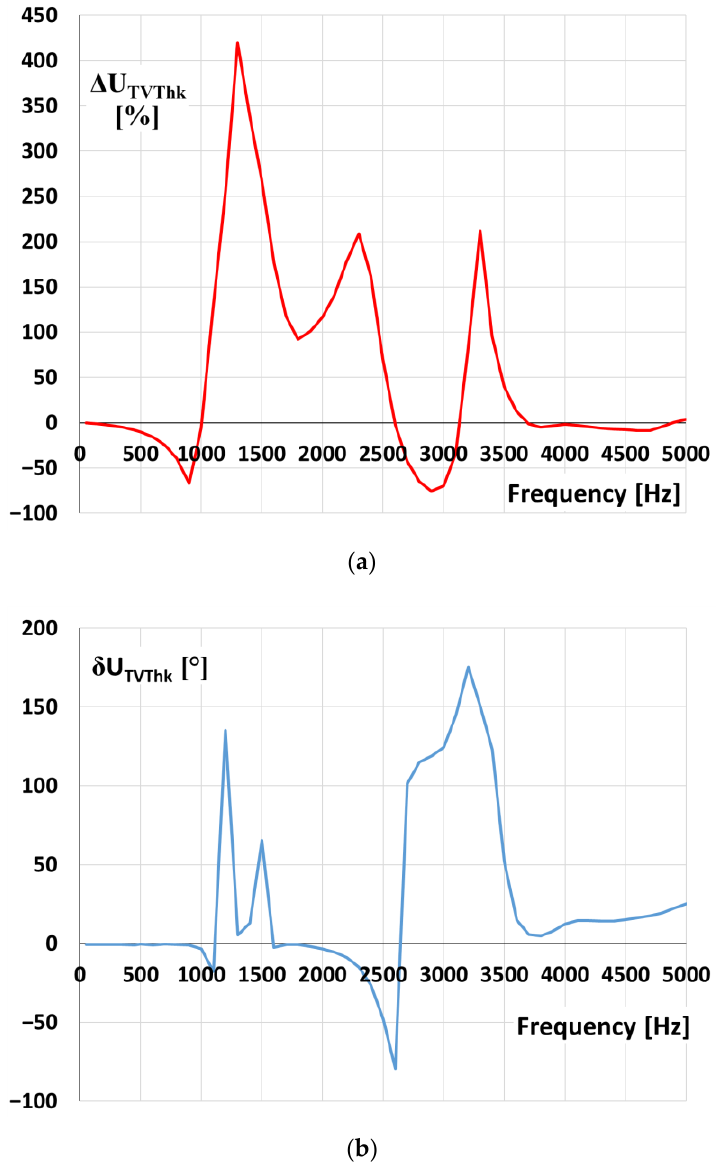
Figure 12. The values of ( a ) voltage error and ( b ) phase displacement at harmonics of the 20 kV voltage transformer (model